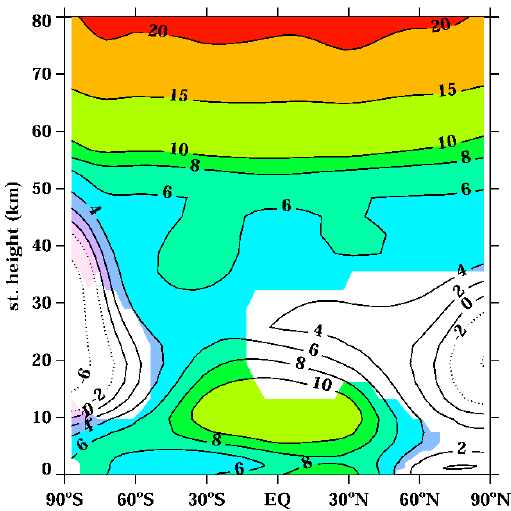
by color shading.